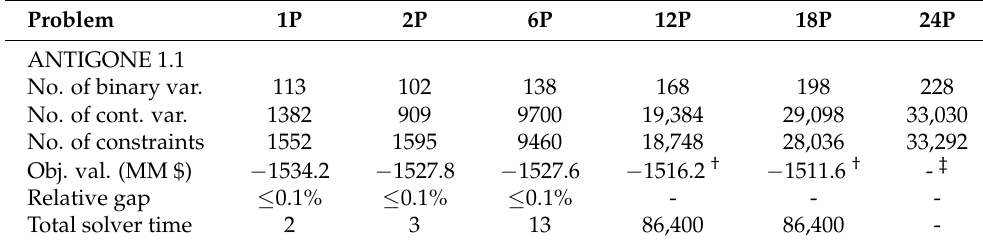
Table 5. Multi-period solution summary for Case B (unit for time: